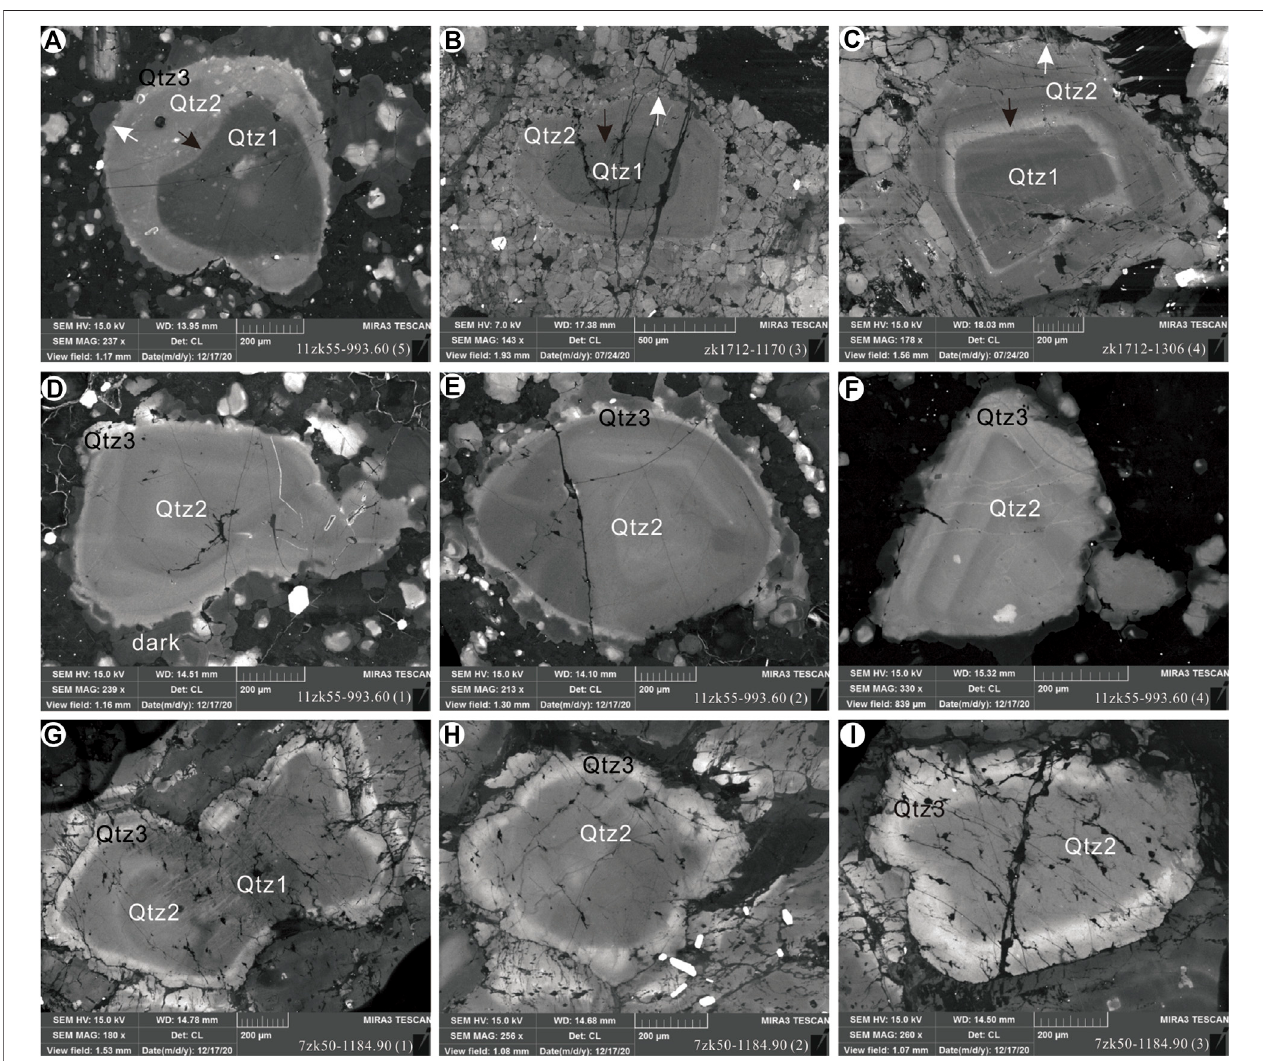
FIGURE 3 | SEM-CL image of quartz from the Hongniu-Hongshan deposit. The quartz from the fi rst generation of quartz (Qtz1) contains a strong dark grey luminescent core (in SEM-CL) with an average diameter of 0.4-0.6 mm ( Figures 3A-C ).The second generation of quartz (Qtz2) has a clear bright grey oscillatory overgrowthzonationwithlayersaveraging0.2mmthick( Figures3D-F ).Thethirdgenerationofquartz(Qtz3)typicallyhasanarrowlightgreyrimontheSEM-CLimages, with have an average thickness of 0.04 mm ( Figures 3G-I ). The black arrow show the resorption surfaces.